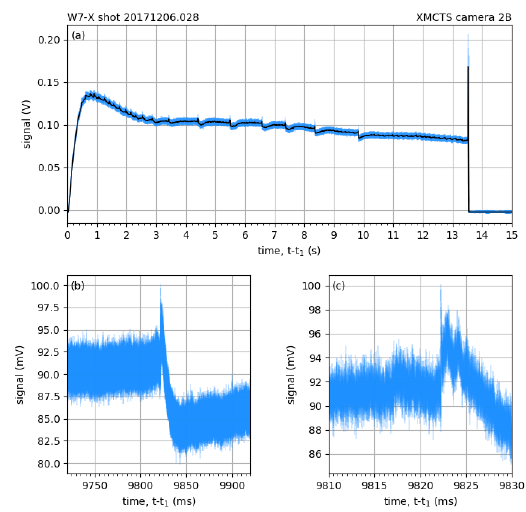
Figure 3 : Soft X rays (XMCTS) data for the analysed discharge. In figure (a) the time traces are displayed. It reproduces main feature of ECE in Figure 3. Plots (b) and (c) are crash zooms and are similar to ECE in Figure 4.